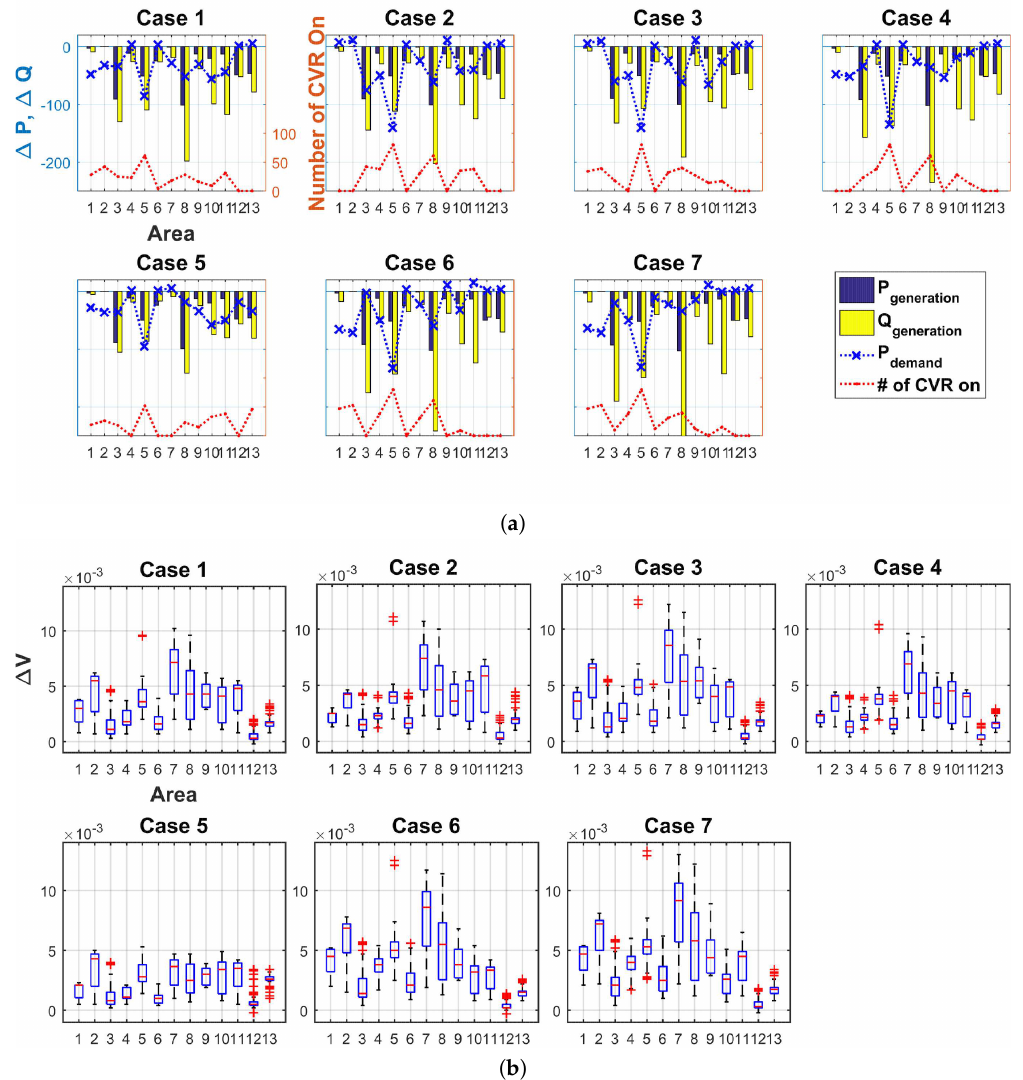
Figure 5. Changes in P, Q ( a ) and V ( b ) after CVR deployment by area compared with a